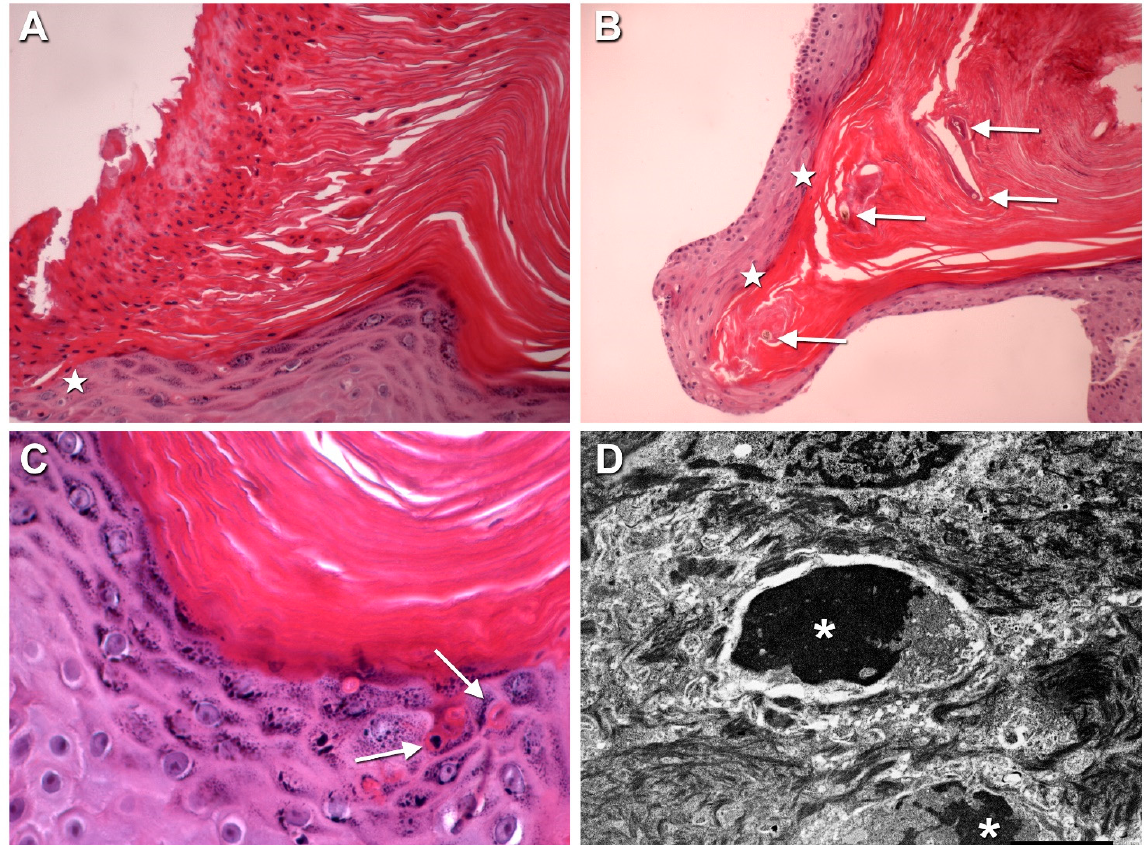
Figure 2. Histopathological and ultrastructural findings. ( A , B ) Histopathological examination of the thigh nodule shaving biopsy shows compact massive hyperkeratosis with a column of parakeratotic cells ( A ), and a keratin plug surrounding a dystrophic vellus hair shaft ( B , arrows); note the focal hypogranulosis below the parakeratotic column (star in A ) and in the epidermis around the keratin plug (stars in B ). ( C ) scattered apoptotic keratinocytes with a pyknotic nucleus and an eosinophilic cytoplasm (arrows) are visible in the upper epidermal cell layers. ( D ) Ultrastructural examination of a follicular papule shows two apoptotic keratinocytes with shrunken condensed nuclei (asterisks) (bar: 2 µ m). ( A – C ): hematoxylin-eosin staining, original magnification 200 × in ( A ), 100 × in ( B ), 400 × in ( C